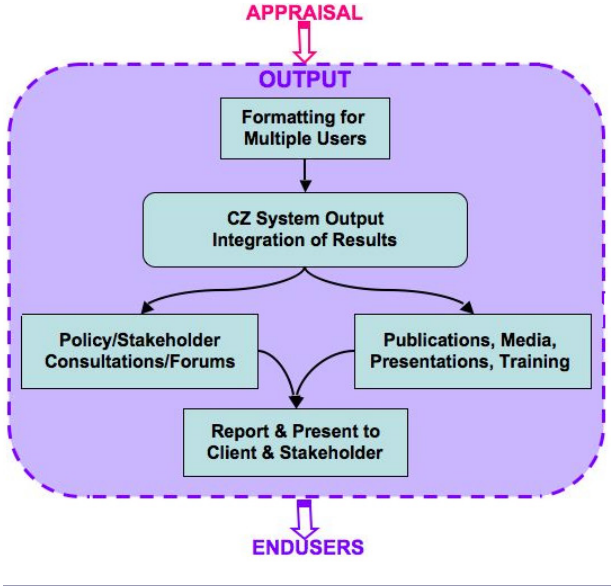
Fig. 9 . Diagram of the activities and products for the Output Step. The main activities are to translate and integrate the final results, consult with the Client/Stakeholder group, construct presentations for various users (media, academic, training, online interactive models, etc.), and submit a summary report as specified in the contract with the